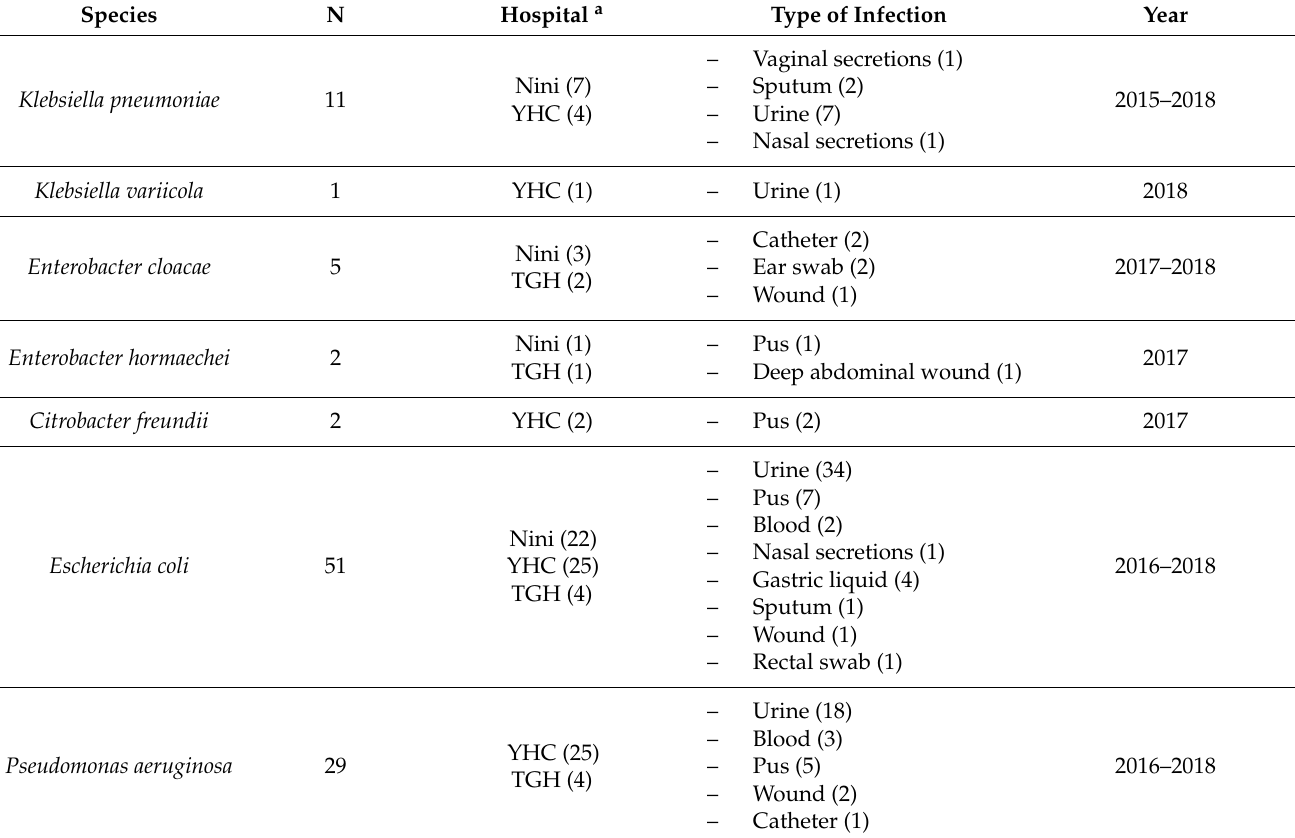
Table 4. Origin and percentage of tested clinical isolates.